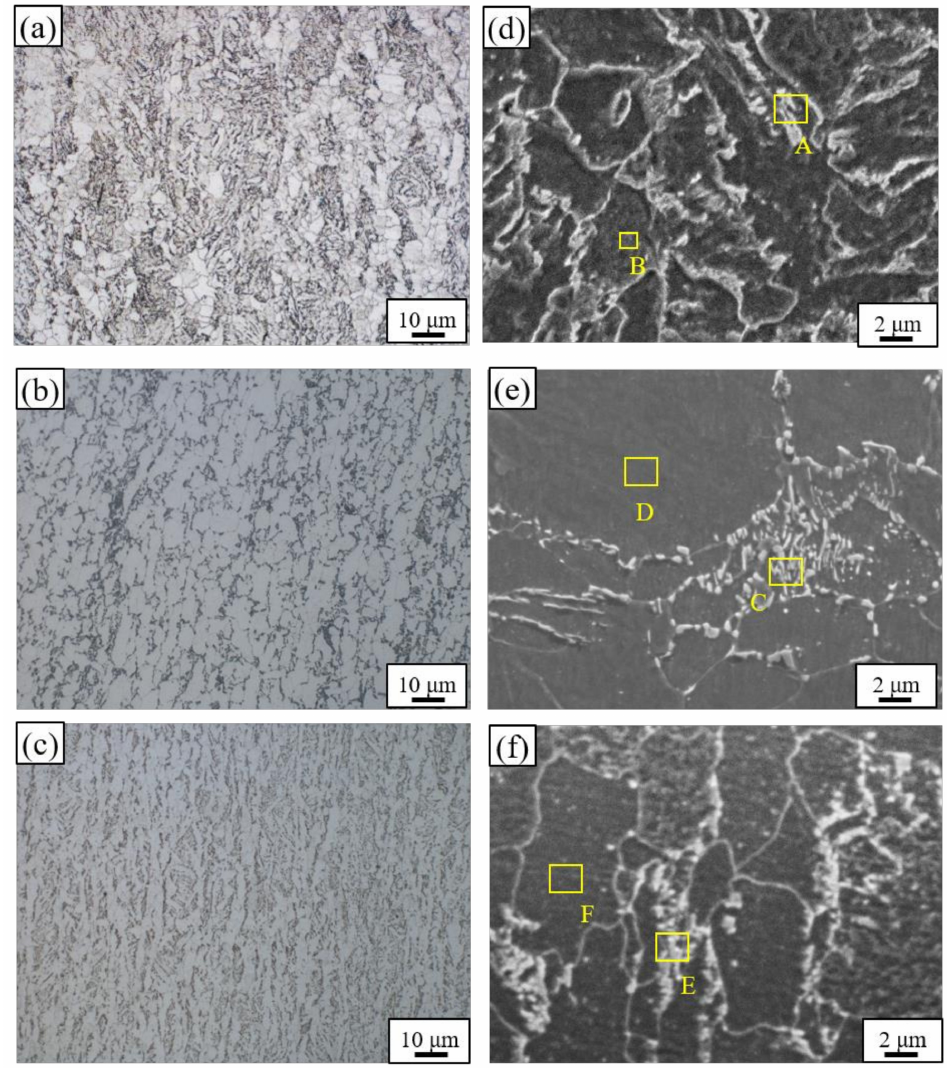
Figure 4. Microstructures of offshore structural steels: ( a , d ) EH36, ( b , e ) FH36T, and ( c , f )